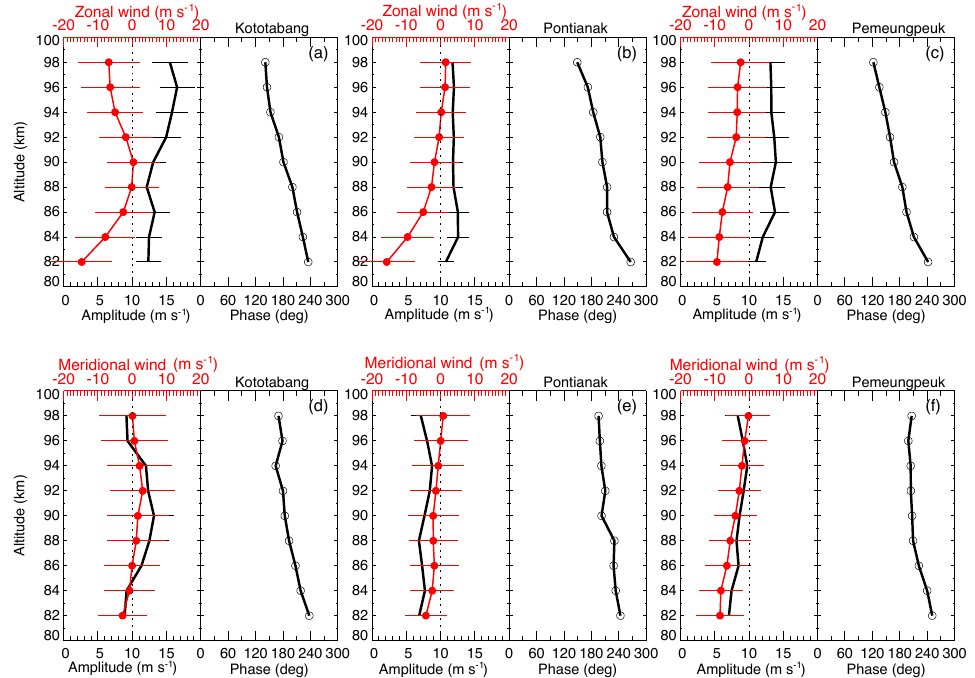
Figure 5. Height profiles of the amplitudes and phases (open circle) of the 3.6-day waves over Kototabang, Pameungpeuk, and Pontianak locations. The thick solid lines represent the mean zonal winds over the period from 1 April to 31 May 2010.